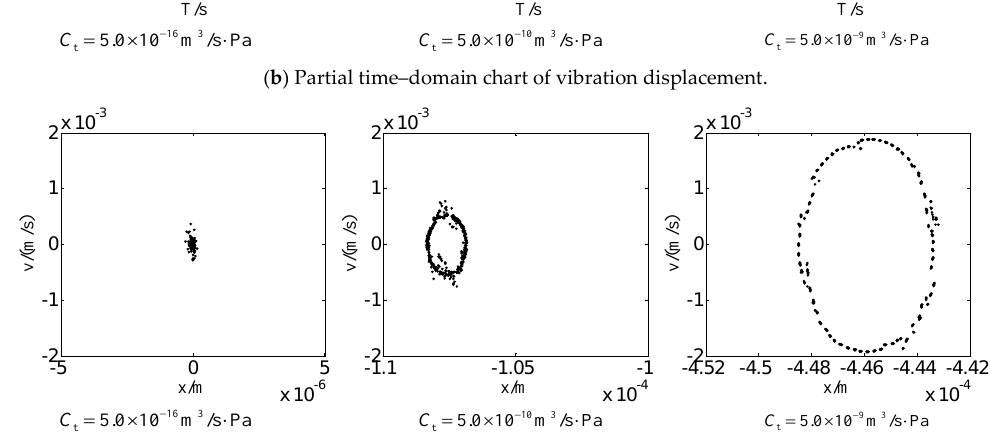
 Figure 7. Effect of leakage coefficient on vibration severity of hydraulic cylinder.